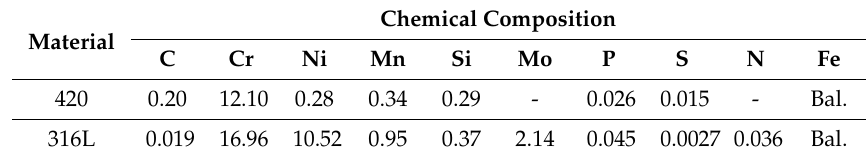
Figure 1. ( a ) Schematic image of the machine, ( b ) shape and size of the vibrating tip, and ( c ) shape and size of the specimen. (Unit: mm). Table 1. Chemical compositions of 420 and 316L.